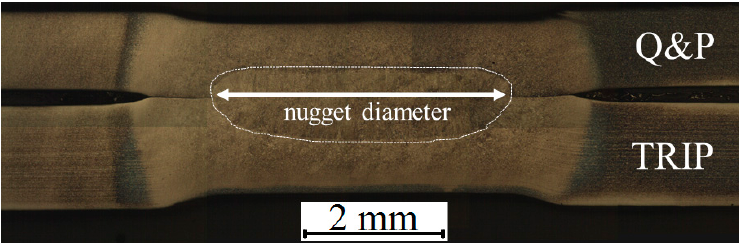
Figure 4. Typical nugget appearance through a centered cross sectional area of a Q&P/TRIP joint after chemical etching. Image from sample no. 1.